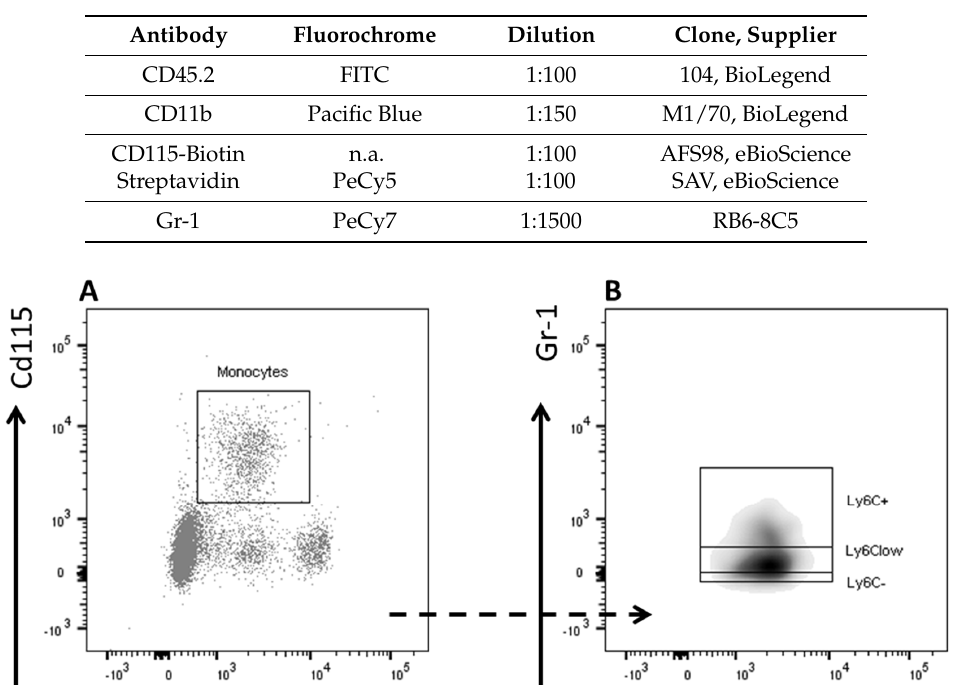
Table 1. Antibodies used for flow cytometry.